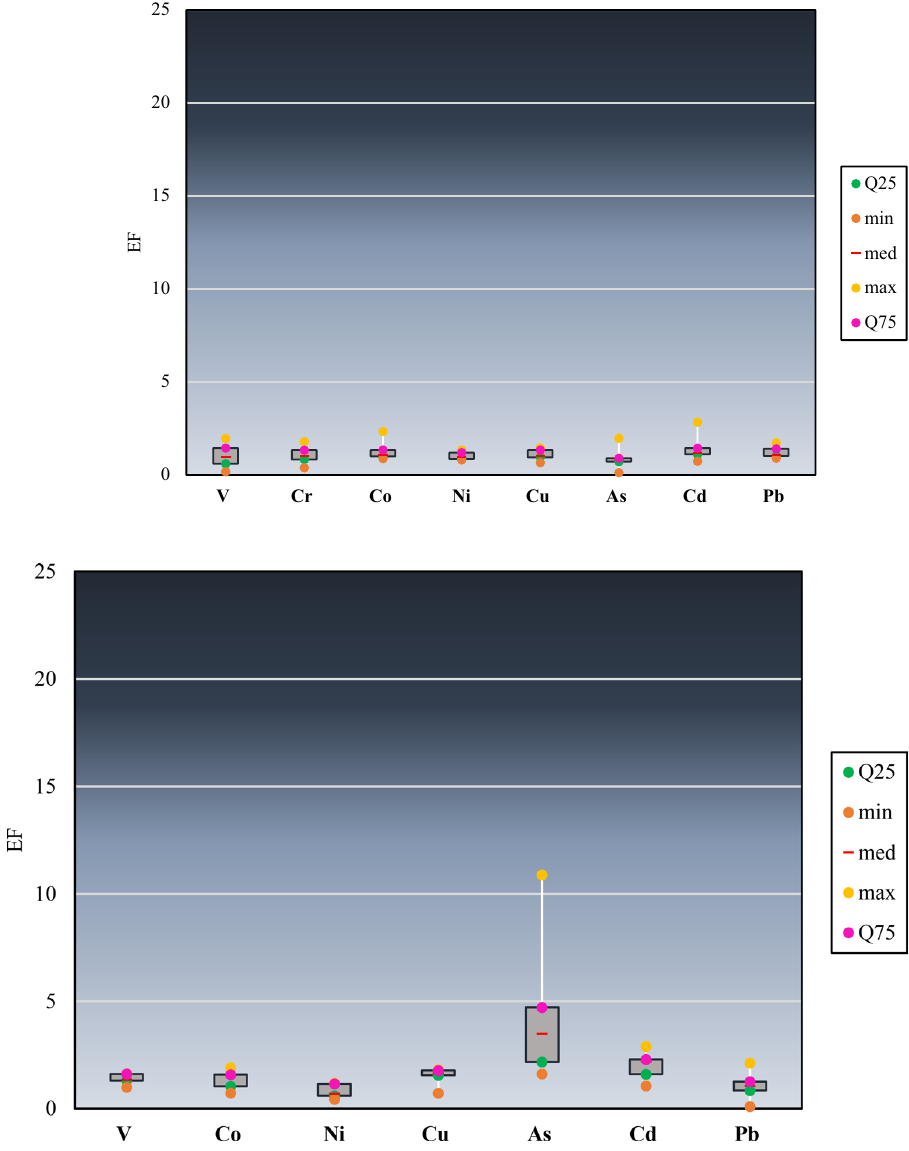
Fig. 12 Enrichment factor (EF) for Cisterna di Latina